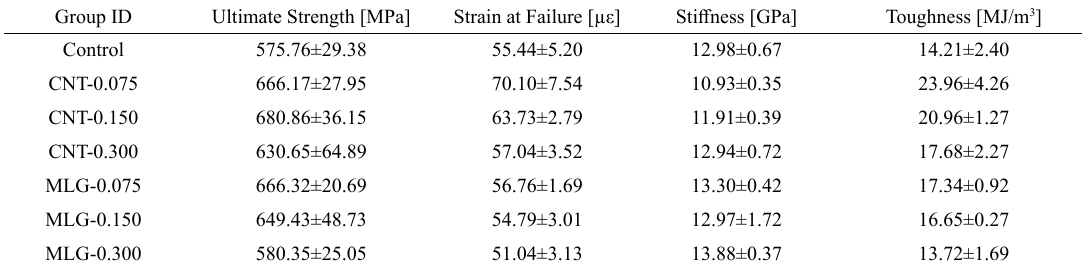
Table 2. Tensile tests summary Group